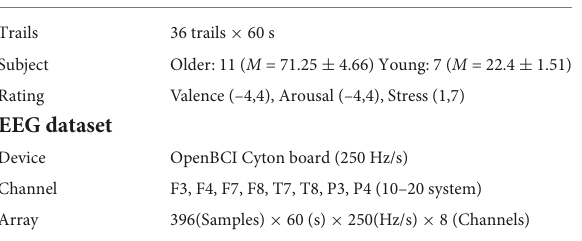
TABLE 2 Summary of experiment dataset